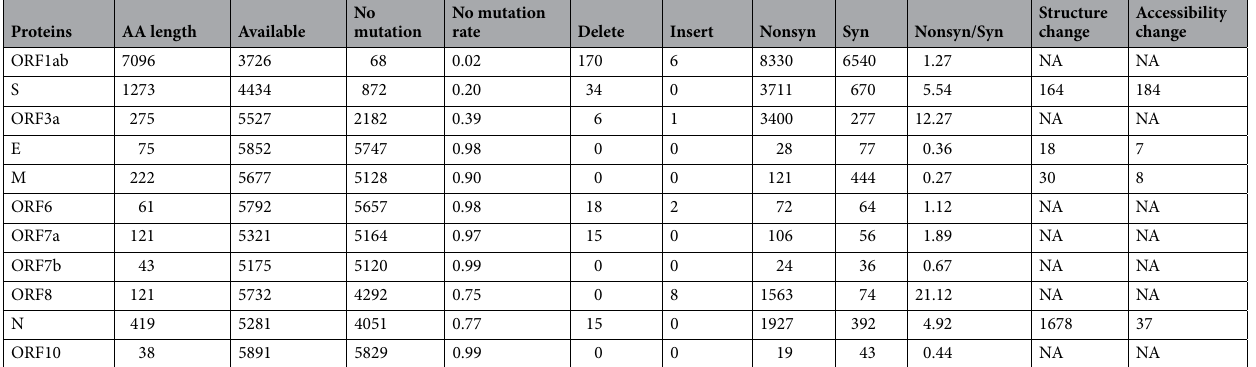
Table 1. Summary of SARS-CoV-2 mutations on each protein and secondary structure and relative solvent accessibility